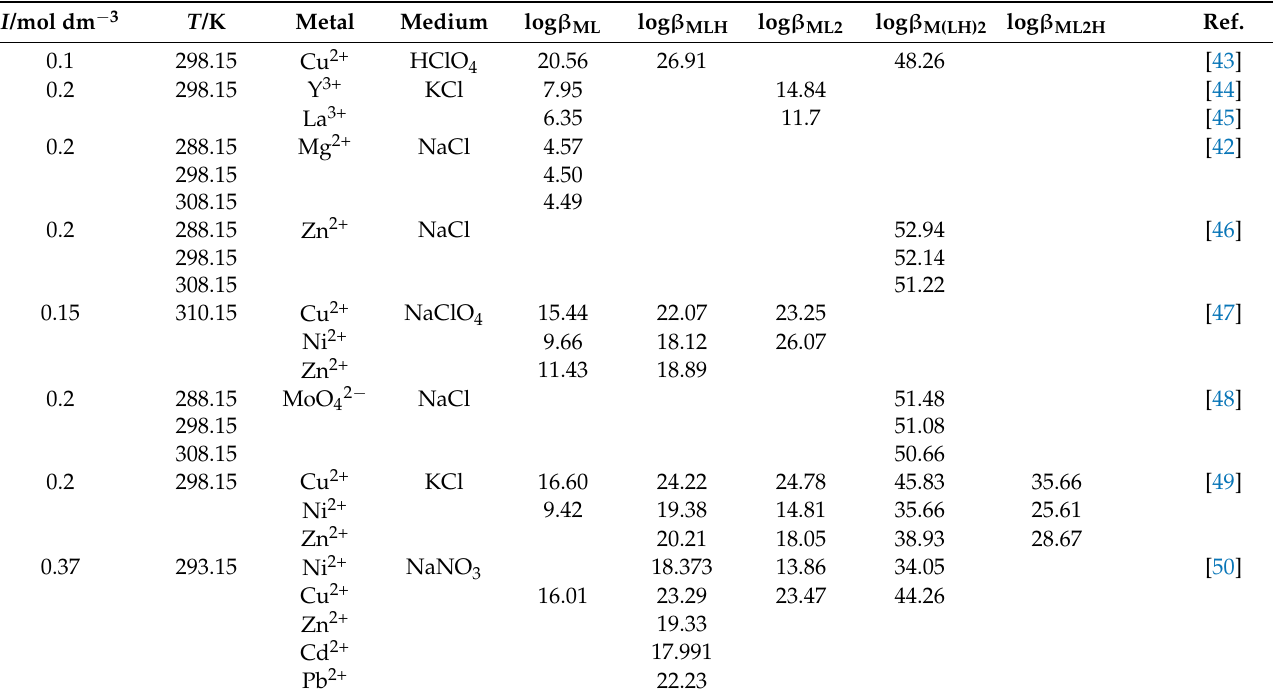
Table 16. Literature data for the complexation of dopamine towards metal